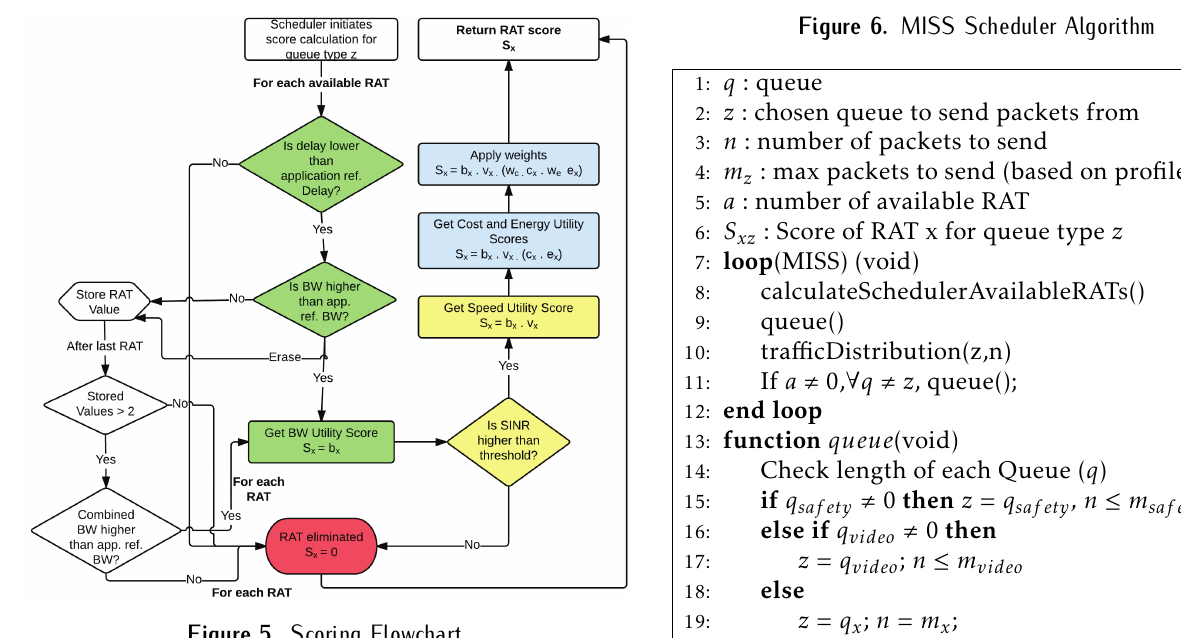
Figure 5. Scoring Flowchart